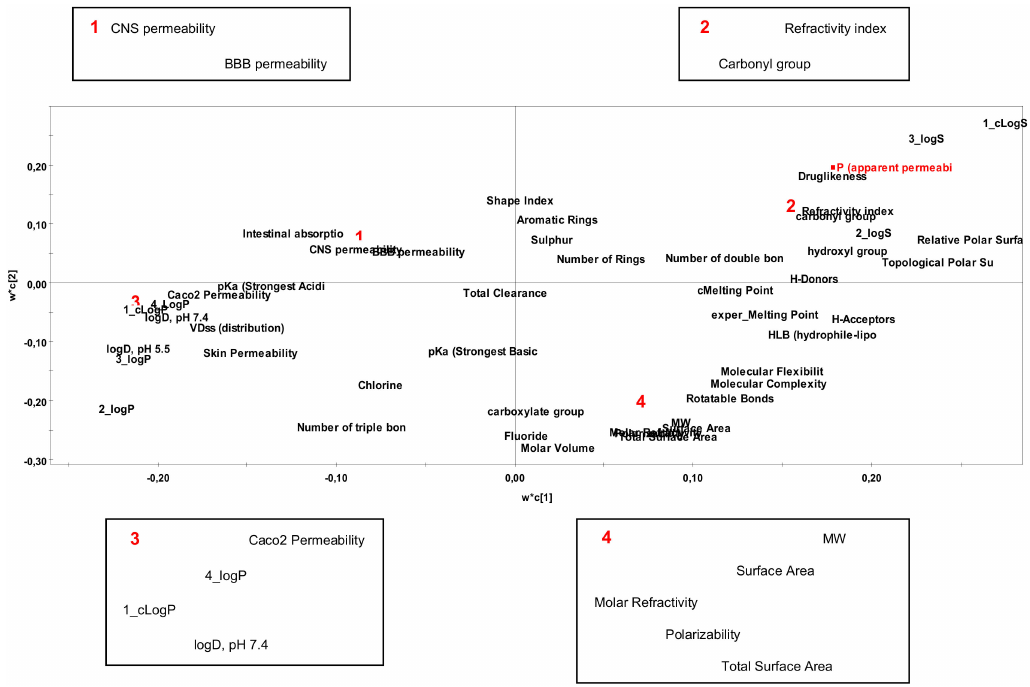
Figure 4. A scatter w × c[1] versus w × c[2] plot for P app